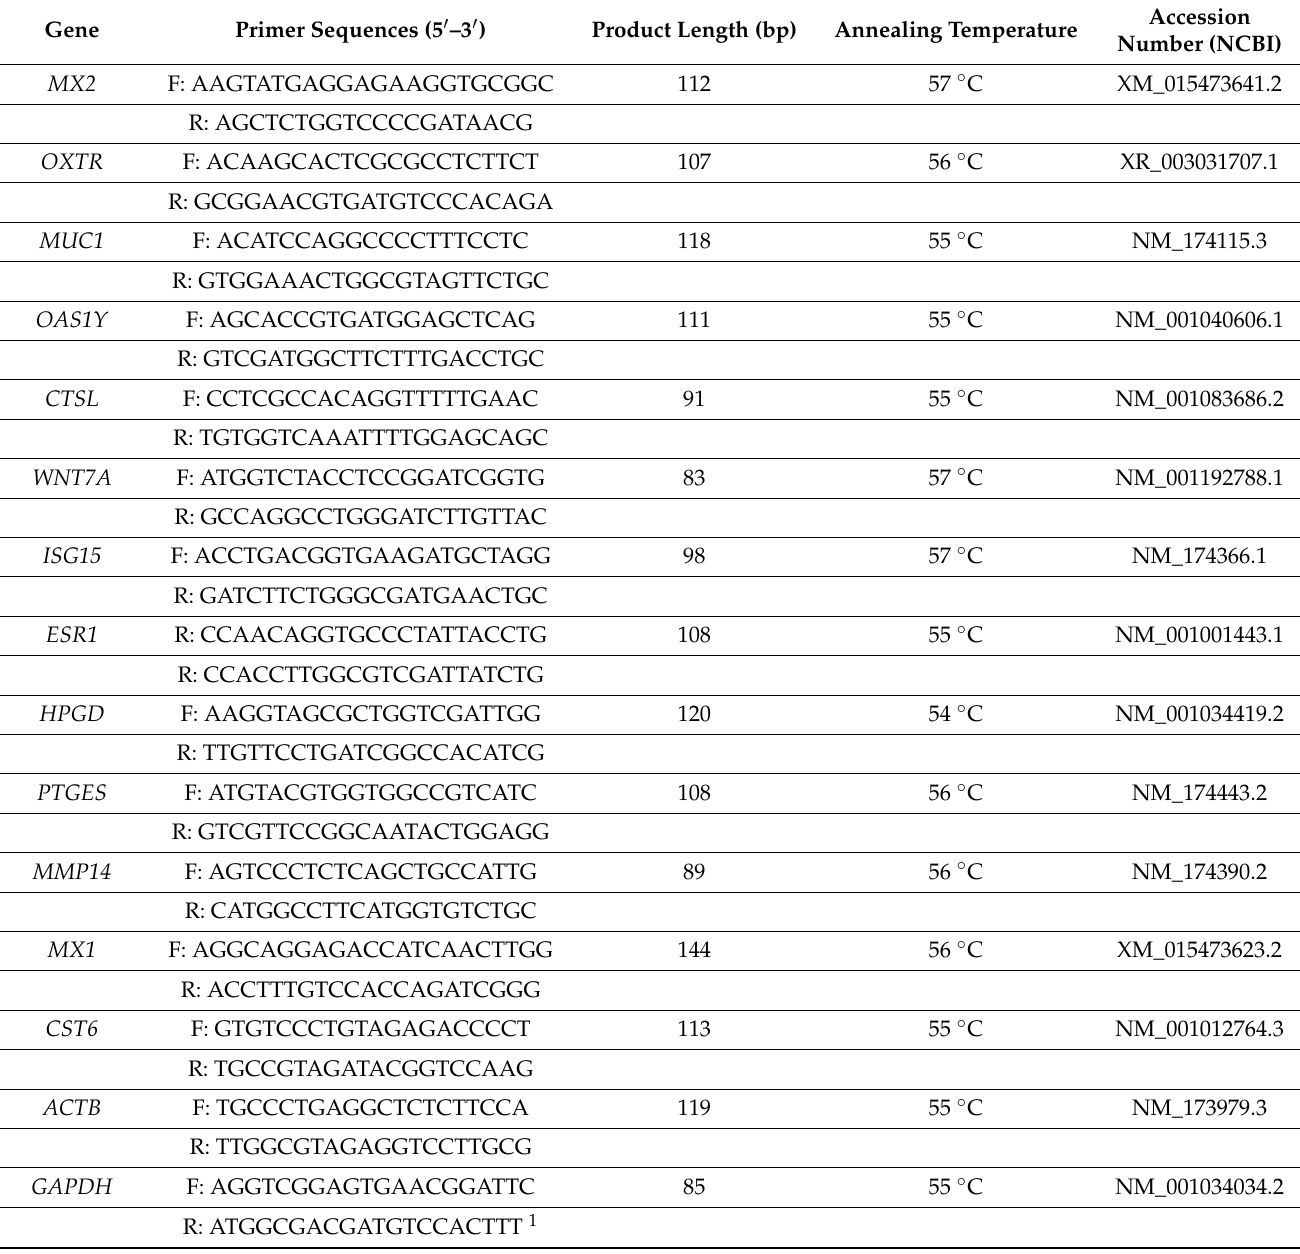
Table 5. Details of primers used for RT-PCR analysis of selected genes for validation of RNAseq